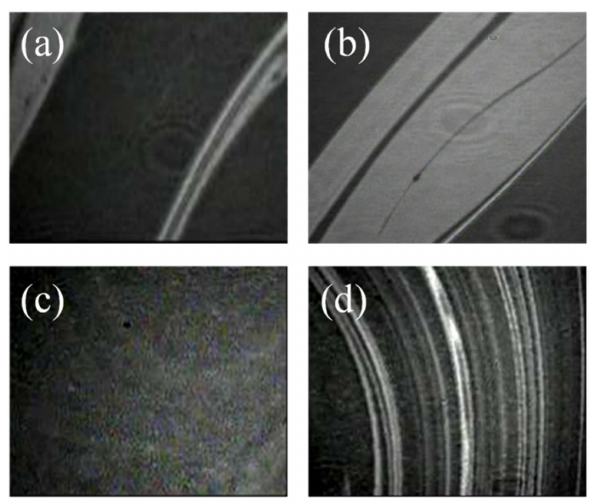
Figure 9. BAM images (width: 500 µ m) of the 4b compound at different surface pressures: ( a ) 0.5 mN ¨ m ´ 1 ; ( b ) 3.0 mN ¨ m ´ 1 ; ( c ) 12.0 mN ¨ m ´ 1 ; and ( d ) 35.0 mN ¨ m ´ 1 .